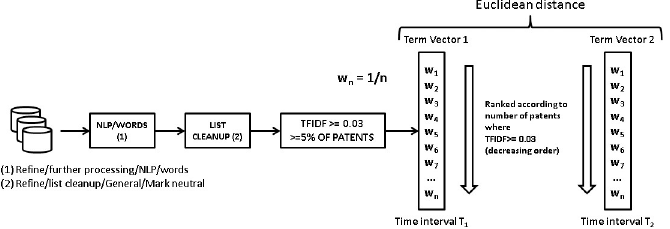
Fig 9. Process for building the term vectors. The information contained in the sub-datasets built in the previous step is text-mined in order to extract the key concepts therein and term vectors are built for each time interval, which will allow us to conduct a comparative analysis across